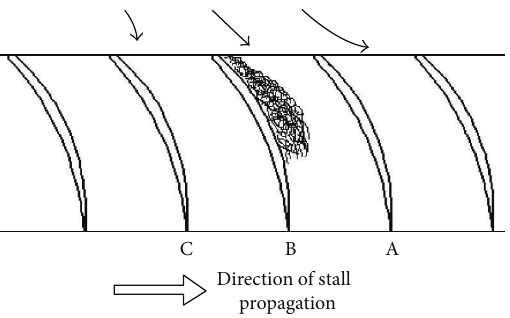
Figure 1: Rotating stall phenomenon in a diffuser.